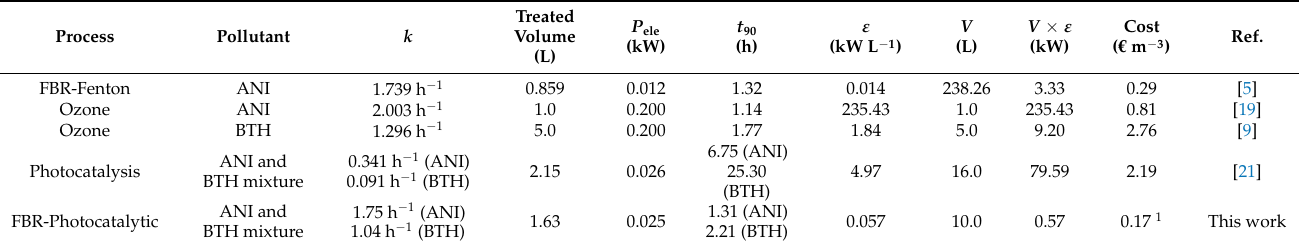
Table 6. Procedure and comparison of ANI and BTH treatment cost estimates.